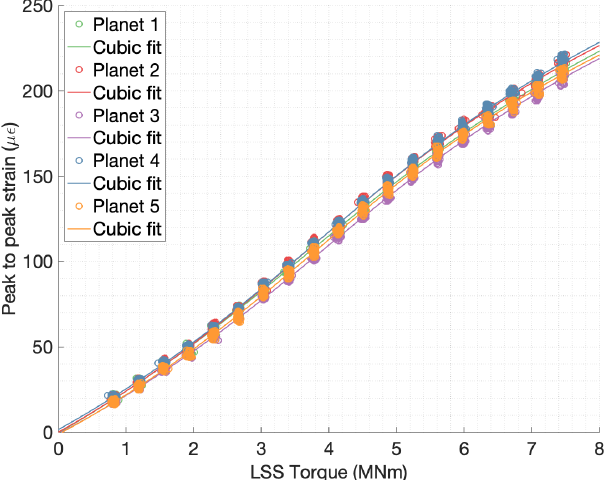
Figure 11. Peak-to-peak strain values of sensor S52 vs. torque in the low-speed shaft separated for each planet and their correspond- ing cubic